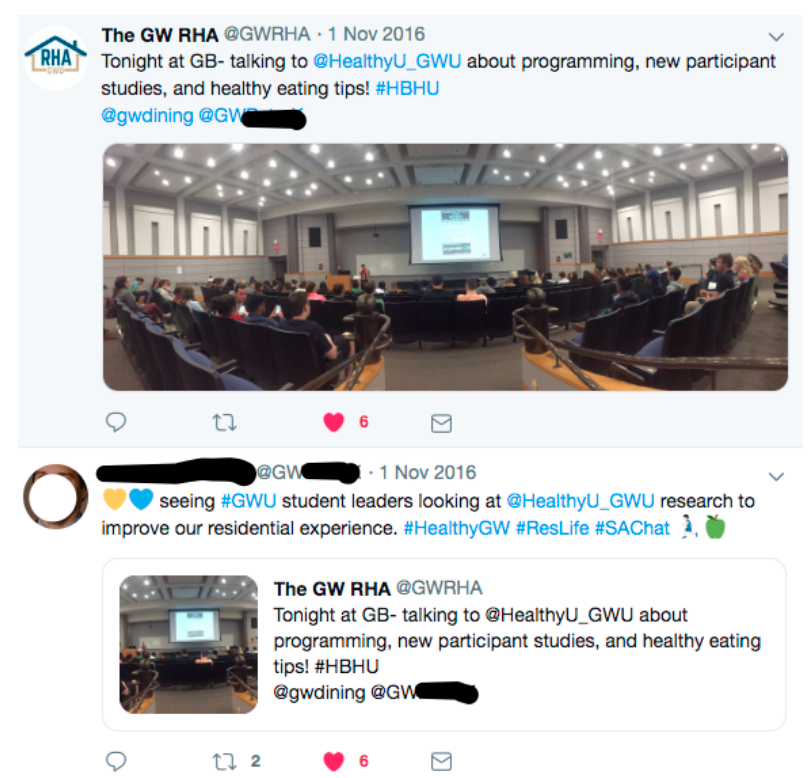
Figure 1. HBCU Facebook post 1.